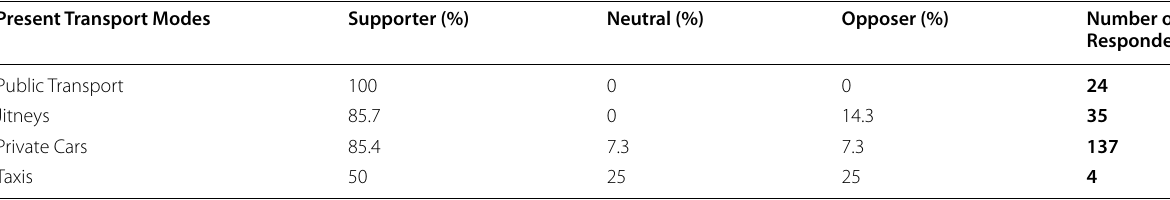
Table 8 Percentages of Supporters, Neutral responses, and Opposers among the users of different travel modes Present Transport